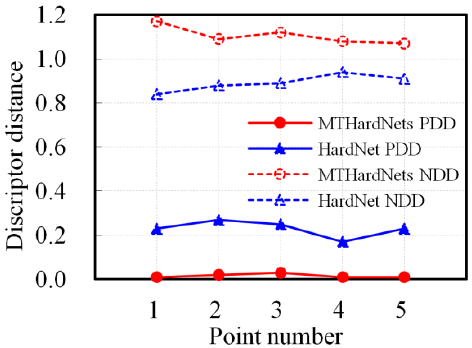
Figure 6. The discrimination comparison between proposed MTHardNets and HardNet de- scriptors by using five pairs of matching points. The PDD is the abbreviation for positive descriptor distance and NDD for negative descriptor